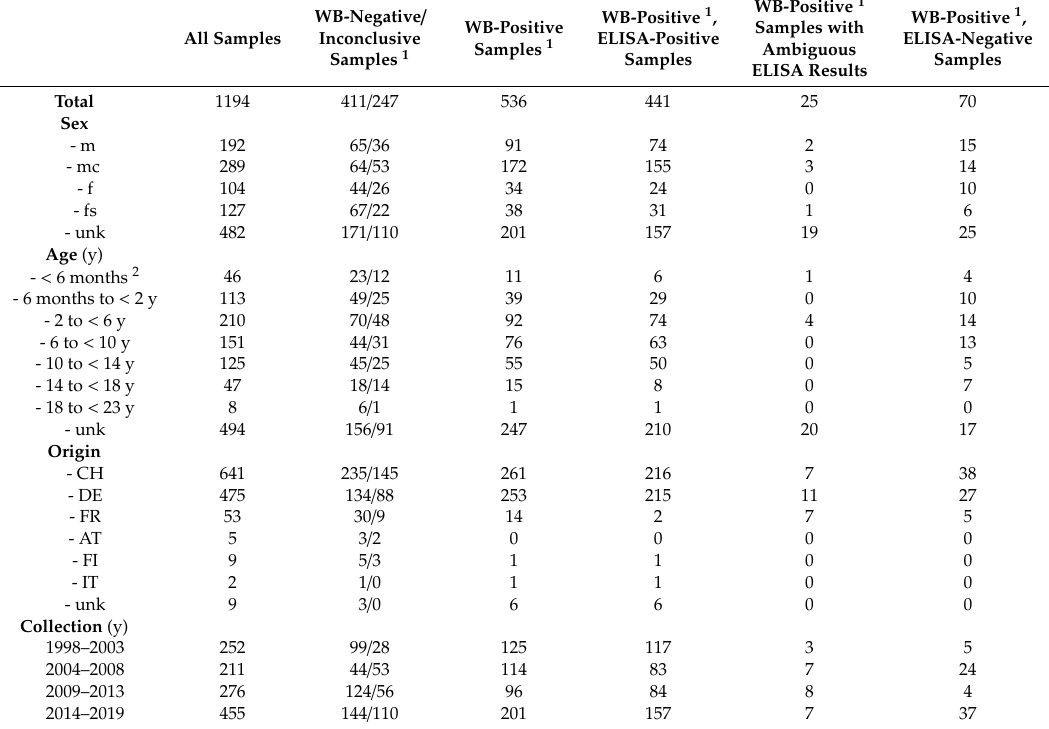
Table 1. Sample characteristics: Sex, age, and origin of the cats that underwent FIV WB and ELISA